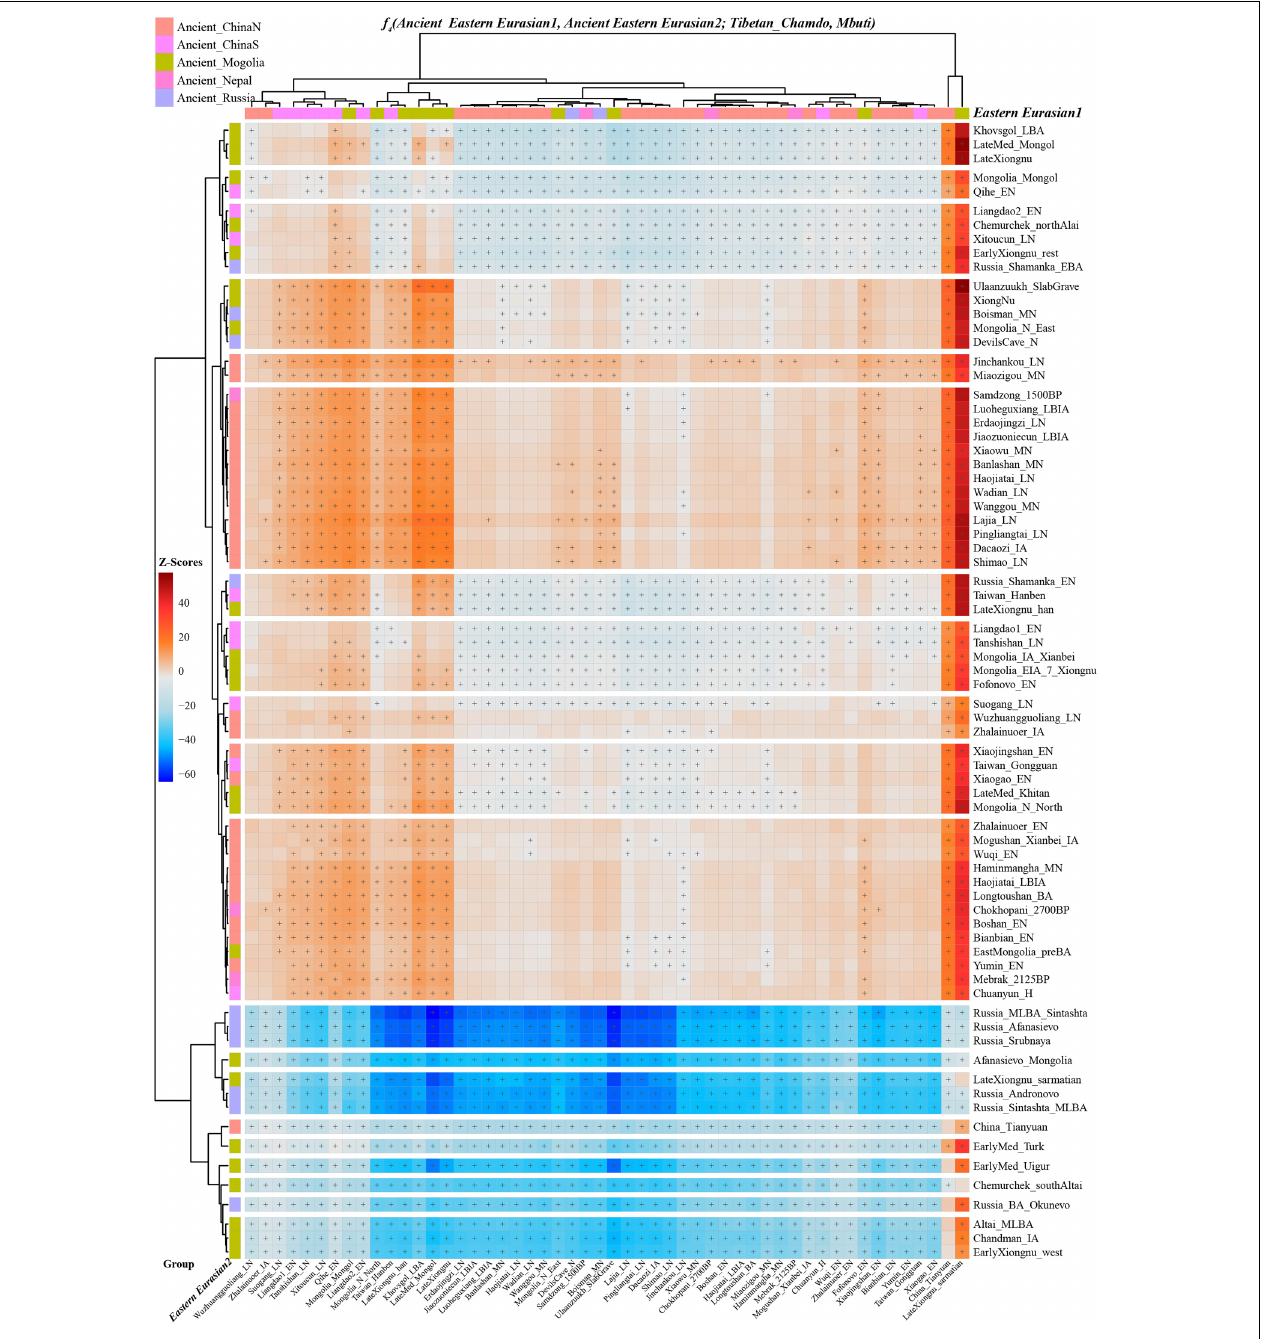
FIGURE 4 | The genomic affinity between Chamdo Tibetans and other eastern Eurasian ancient populations inferred from four population affinity-f 4 statistics of the form f 4 (Ancient Eastern Eurasian1, Ancient Eastern Eurasian; Tibetan_Chamdo, Mbuti). Red color with statistically significant f 4 -values (marked with “+”) demoted Chamdo Tibetans shared more derived alleles with Ancient Eastern Eurasian1 (right population lists) compared with Ancient Eastern Eurasian2 (bottom population lists). Blue color with significant f 4 -values denoted Chamdo Tibetans shared more Ancient Eastern Eurasian1-related derived alleles relative to their